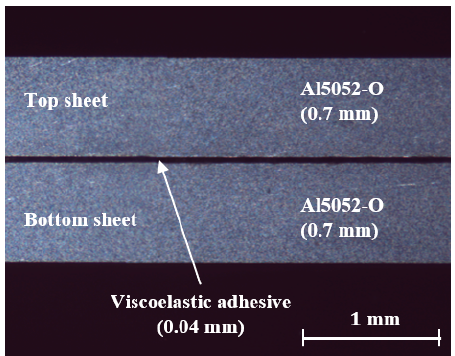
Figure 1. Vibration-damping aluminum (Al) panel cross-sectional view under an optical microscope. Table 1. The ultimate tensile strength and thickness of the materials tested here. The results for three different directions ( 0 ° , 45°, and 90°) are shown for carbon-reinforced plastic (CFRP).